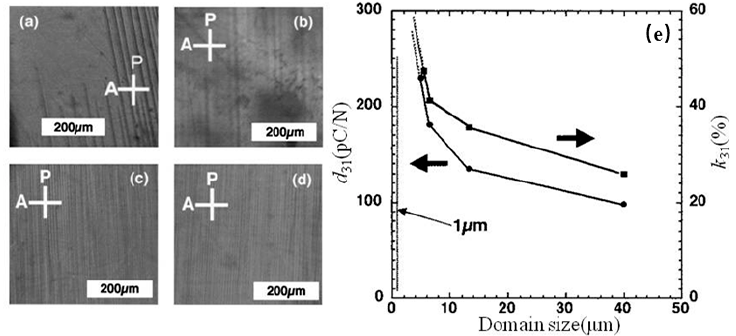
Figure 4. ( a – d ) Domain configurations of 31 resonators with different domain sizes ranging from 5.5 μ m to 40 μ m. ( e ) Domain size dependence of d 31 and k 31 for <111> c -poled BaTiO 3 single crystals [34].